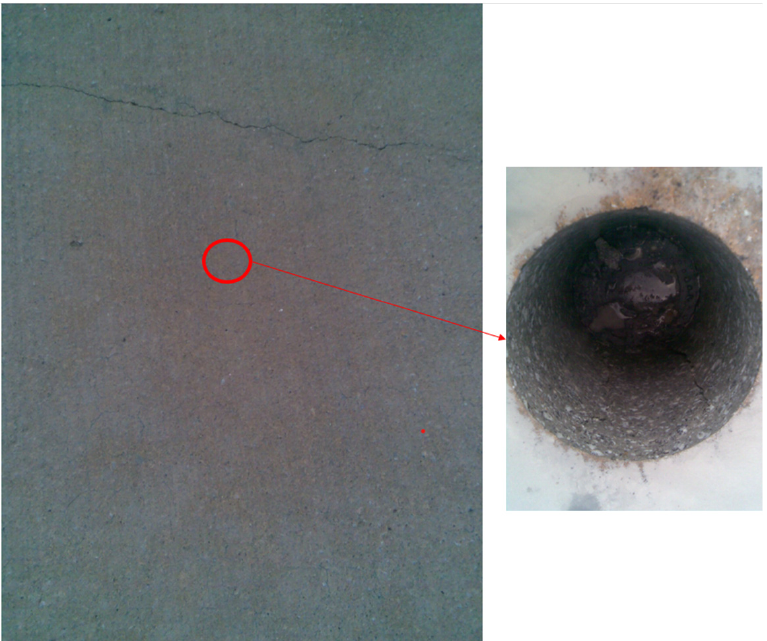
Figure 1. The operated airport rigid pavement with a visible color change within the area of so-called stream core and the place from which the test core was taken.